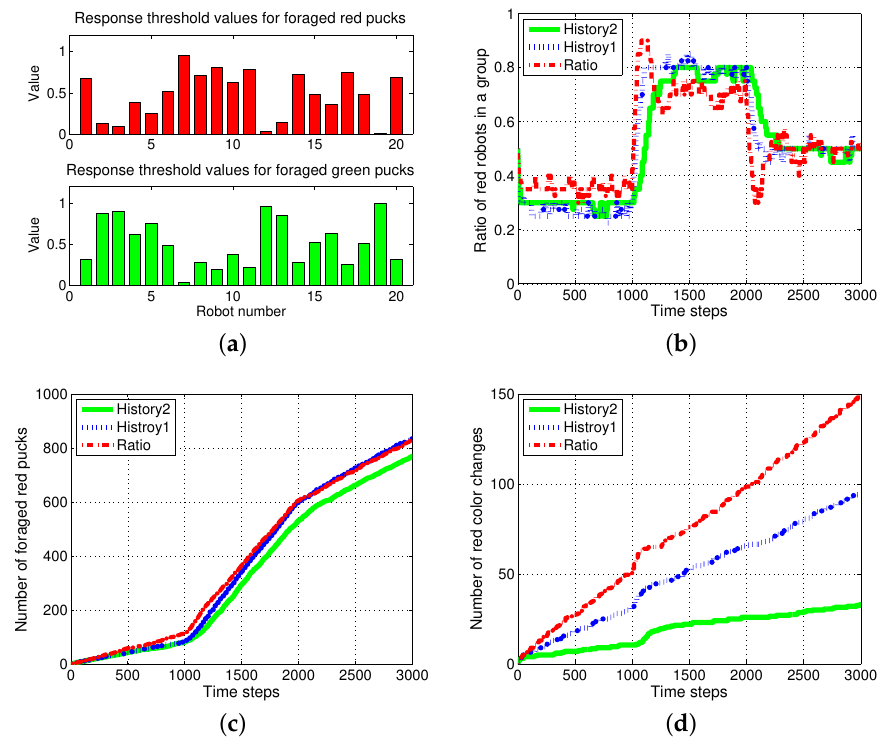
Figure 13. Randomly distributed pattern for response threshold values for two foraging tasks. ( a ) Response threshold value in a random pattern; ( b ) ratio of robots for red pucks in a group; ( c ) number of foraged red pucks; ( d ) number of task switches for red